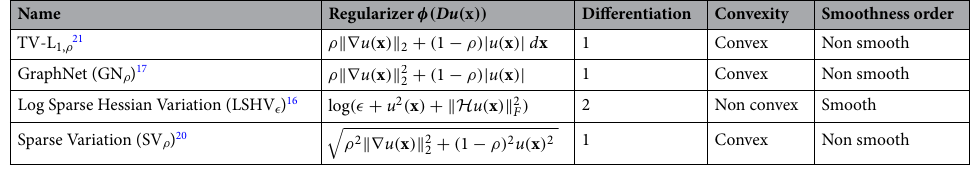
Table 2. Properties of sparse